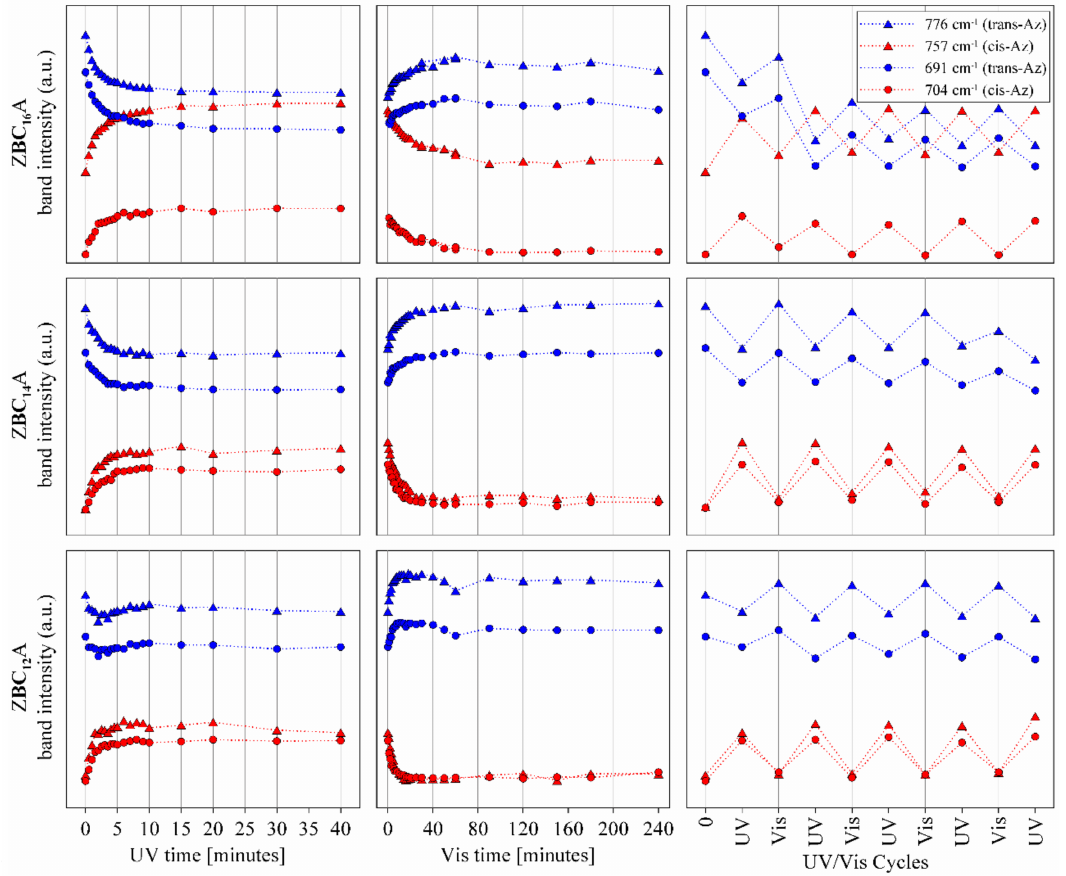
Figure 9. The 776, 757, 691, and 704 cm − 1 bands intensities versus UV or Vis irradiation time and under alternating UV–Vis treatment. The band intensities were determined after the spectra decomposition using the Omnic software (Gaussian / Lorentzian